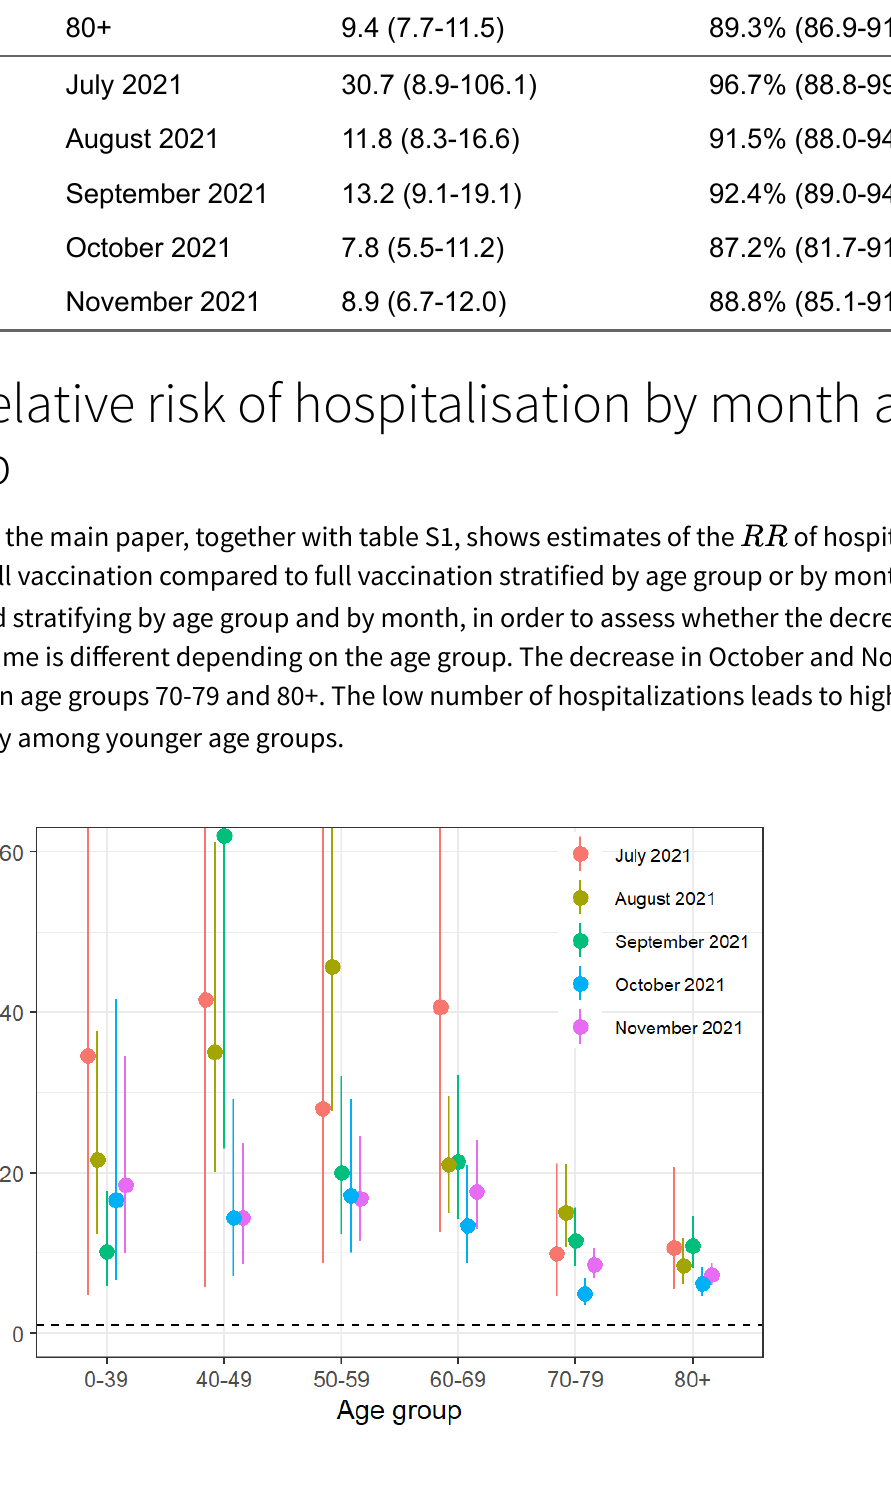
Figure S3. Relative risk of hospitalization for non-vaccinated individuals compared to vaccinated individuals stratified by age group and